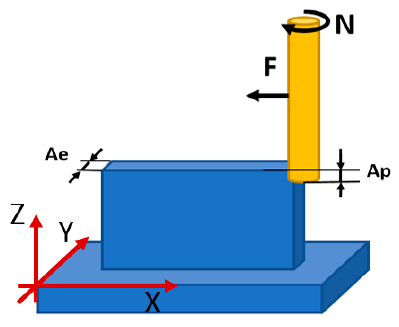
Figure 4. Tool path for the face milling.